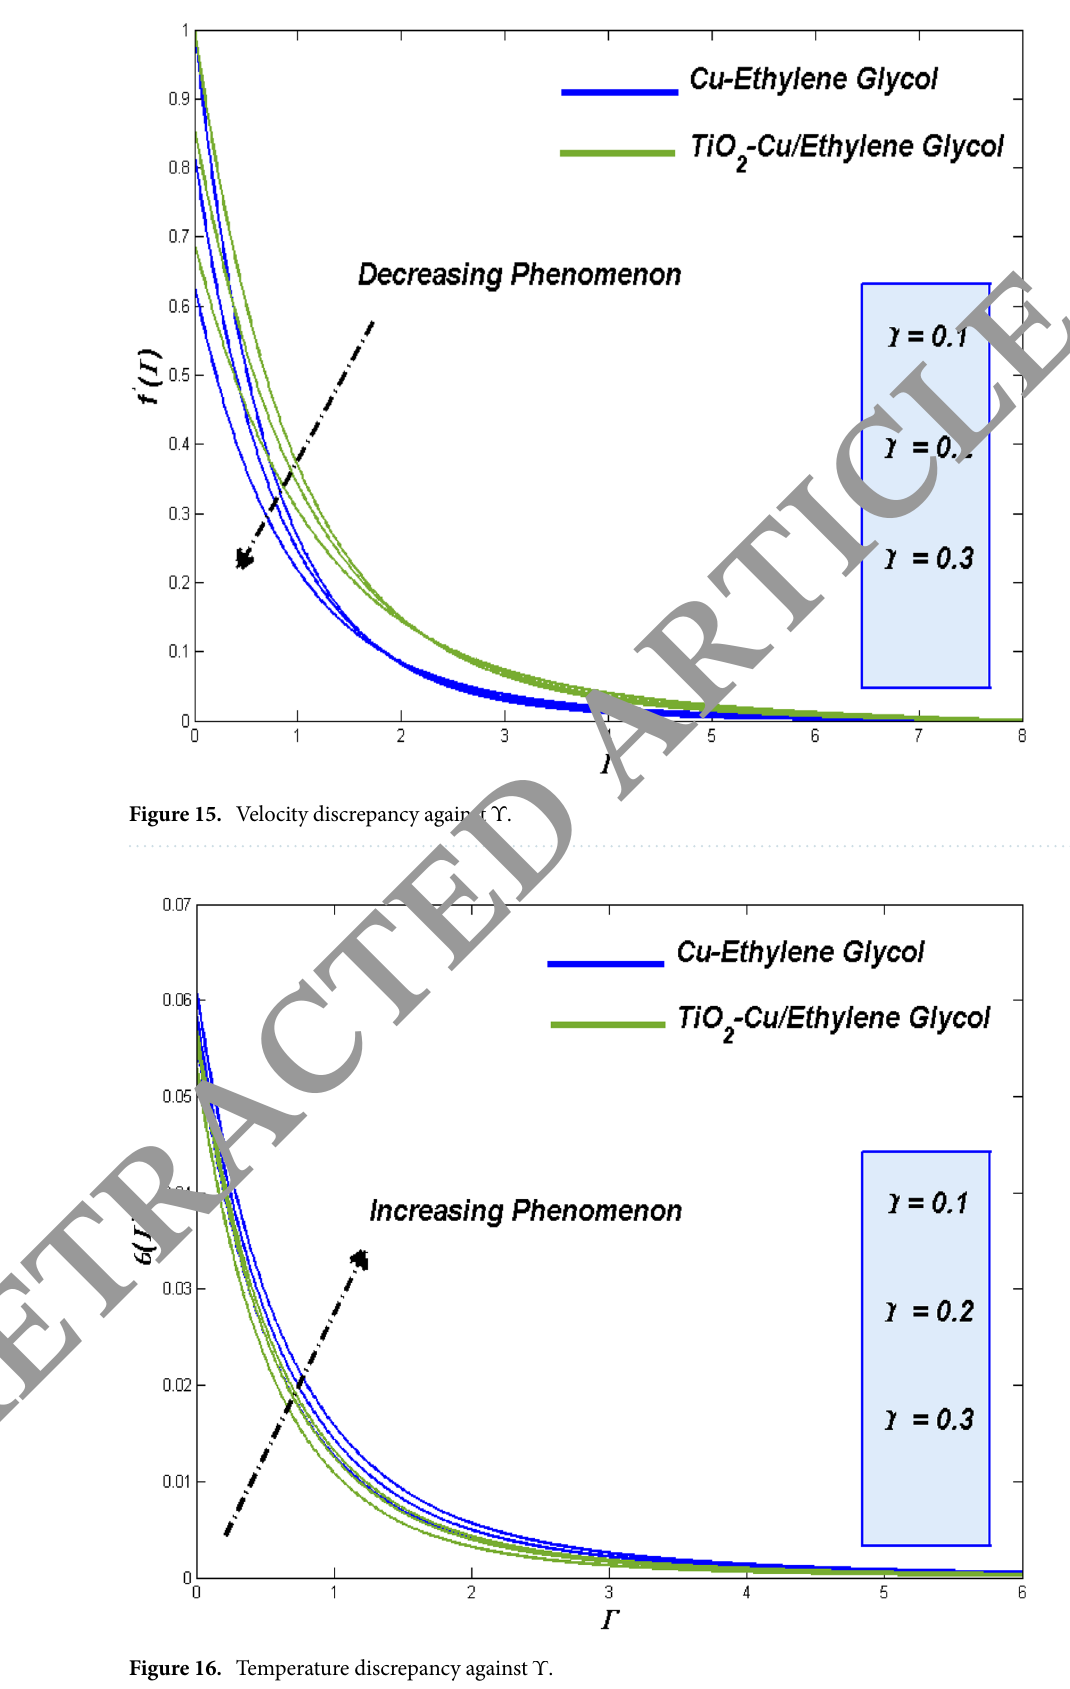
Figure 16. Temperature discrepancy against ϒ